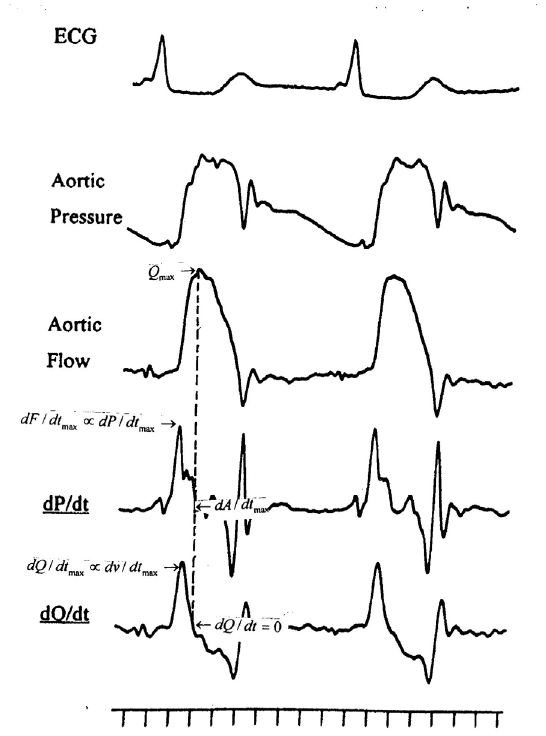
Fig. 1. ECG, aortic pressure, aortic blood flow Q, aortic rate of change of pressure dP/dt, and rate of change of flow, which is acceleration dQ/dt. From a canine model In: Li J-K. The arterial circulation: physical principles and clinical applications. Totowa, NJ: Humana Press; 2000, p.